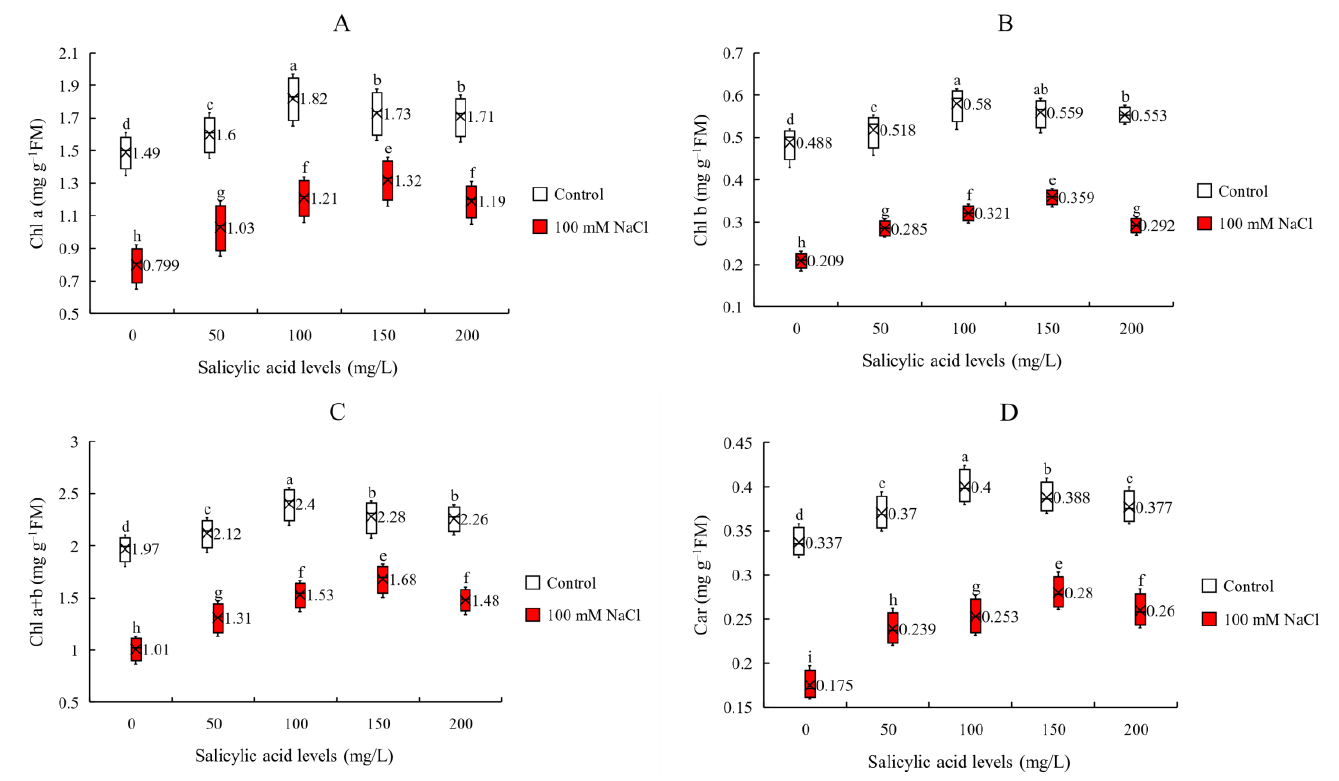
Figure 3. The contents of ( A ) chlorophyll a (Chl a), ( B ) chlorophyll b (Chl b), ( C ) total chlorophyll (Chl a+b) and ( D ) carotenoids (Car) of sorghum plants for the interaction of SA treatments × salinity (100 mM NaCl) in four repetitions at fifty percent flowering stage. Different letters indicate significant differences by HSD at p < 0.05. The data for analysis are given in Table S1.